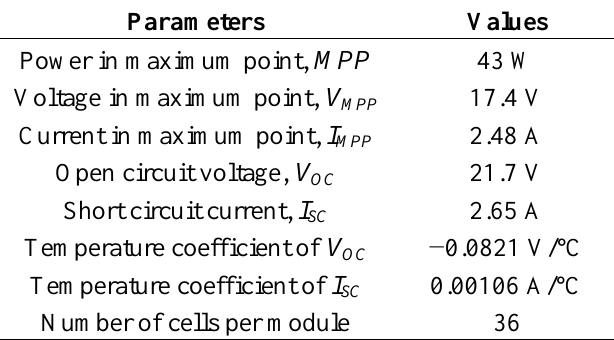
Table 2. Specifications of Solar KC40T at 1000 W/m 2 and 25